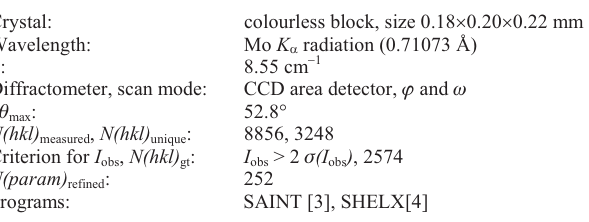
Table 1. Data collection and handling.